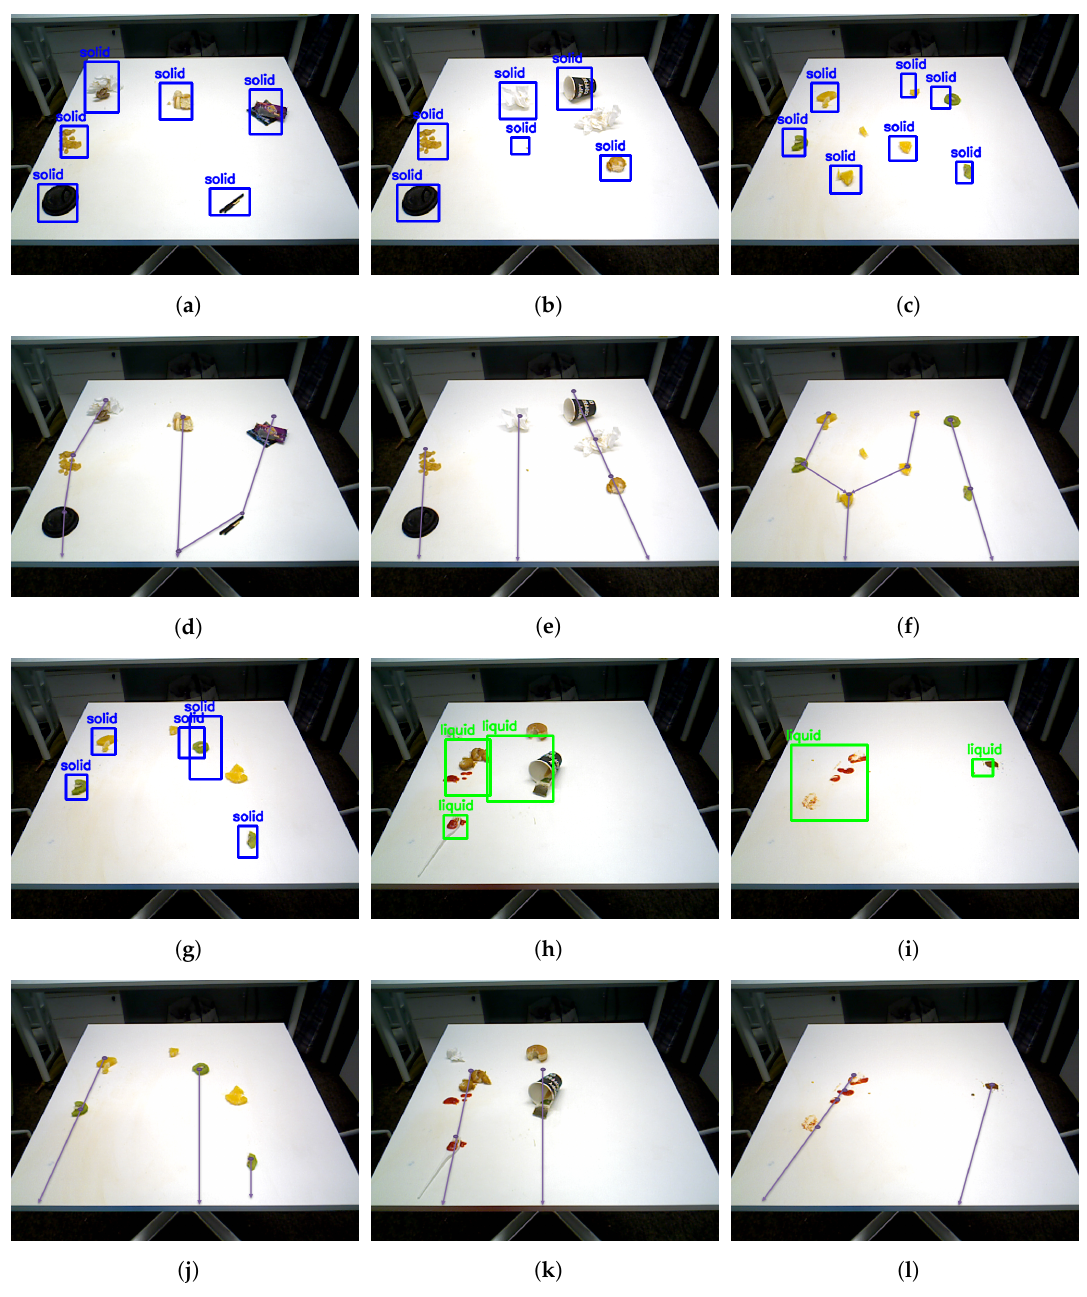
Figure 9. ( a – c , g – i ): Food litter detection results, ( d – f , j – l ): Cleaning path map for detection